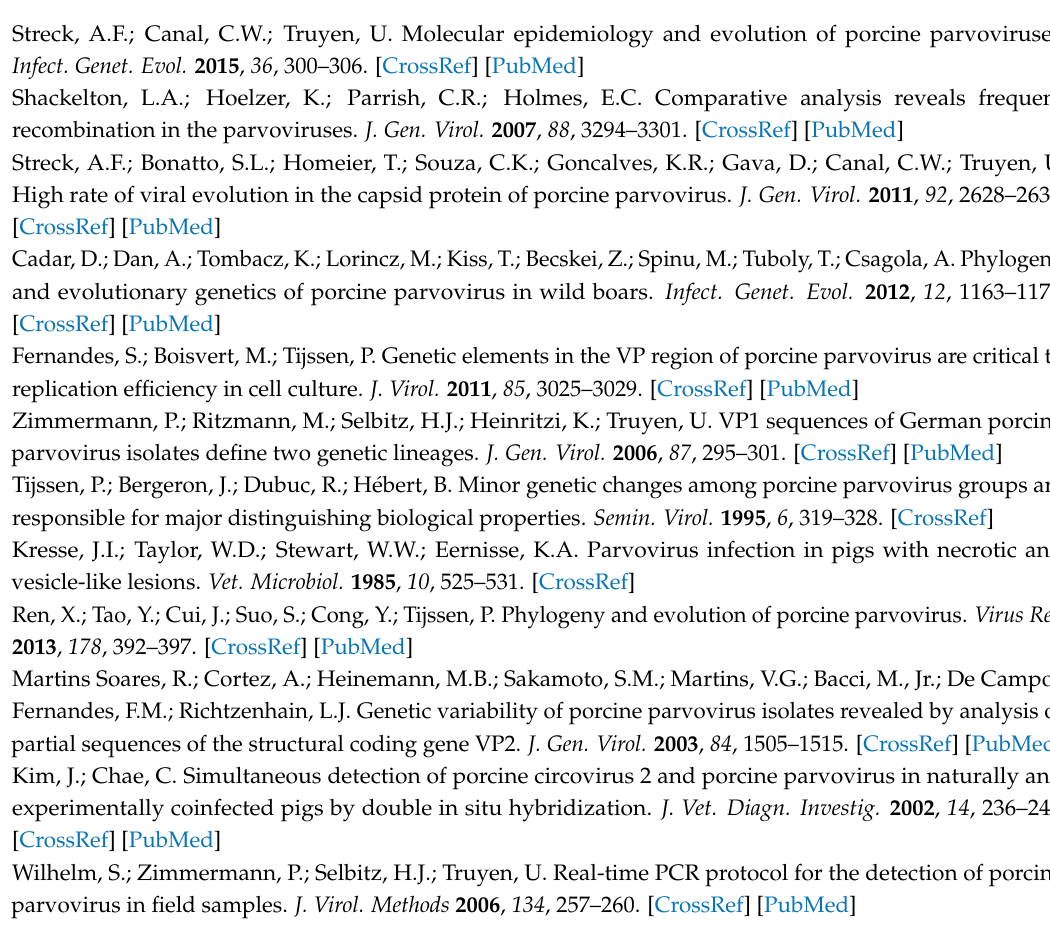
Table S1: Result of retrospective detection of PPV in nine provinces of South Korea from March 2013 to March 2017; Table S2: List of NS1, VP1, and VP2 sequences used in this study. The strain isolated in South Korea 2016 was named T142_South Korea in this study; Table S3: Additional data about similarity values of nucleotides and amino acids between strain 1–5 and other 70 strains (back data for table 4) (Strain 1–5: sample collected 1900–2000, Strain 6–22: 2001–2005, Strain 23–49: 2006–2010, Strain 50–75: 2011–2016) (Strain 1: Kresse, Strain 2: Germany IDT, Strain 3: NADL2, Strain 4: Challenge, Strain 5: China 1989; Accession numbers: U44978.1, AY684872.1, NC_001718.1, AY684866.1, HM989009.1); Table S4-1: Detailed information about 28 highly variant regions of amino acid substitutions made in VP2 gene of strain Kresse and 74 other strains; Table S4-2: Detailed information about 28 highly variant regions of amino acid substitutions made in VP2 gene of strain NADL-2 and 74 other